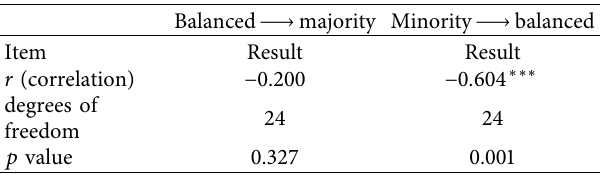
Table 5: The repeated measurement correlation under balan- ced ⟶ majority condition and minority ⟶ balanced condition.